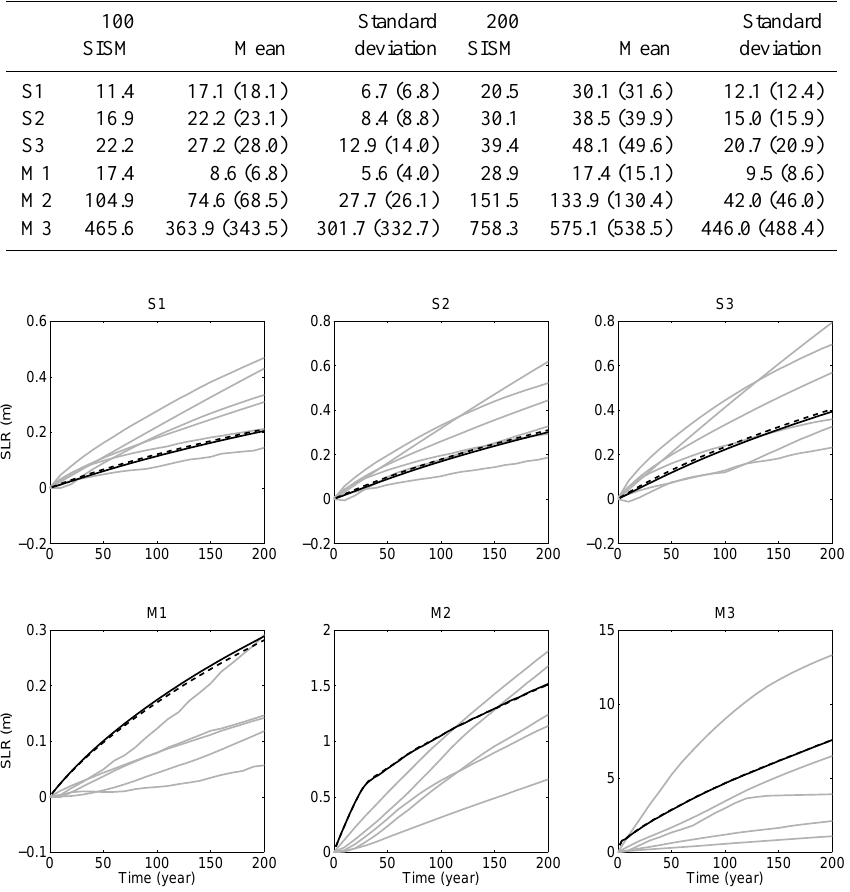
Table 2. Global sea-level increase (cm) projected by SISM after a 1000-year spin-up, together with mean and standard deviation pro- jected by the SeaRISE models extended with SISM (described in Sect. 2.3) or SeaRISE models alone (in brackets) for each experiment at 100 and 200 years. Note that similar numbers are presented in Bindschadler et al. (2013) but a different sea-level conversion factor was used (4.0 × 10 14 m 3 equivalent to 1m mean sea level).